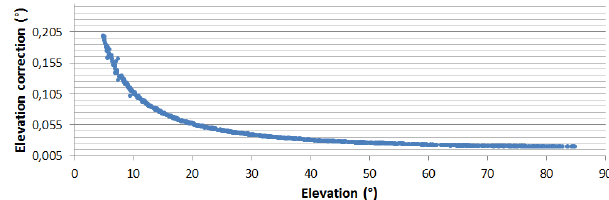
Figure 6. Effect of the neutral atmosphere on the elevation angle. An exponential correction must be made for satellites with low ele- vation